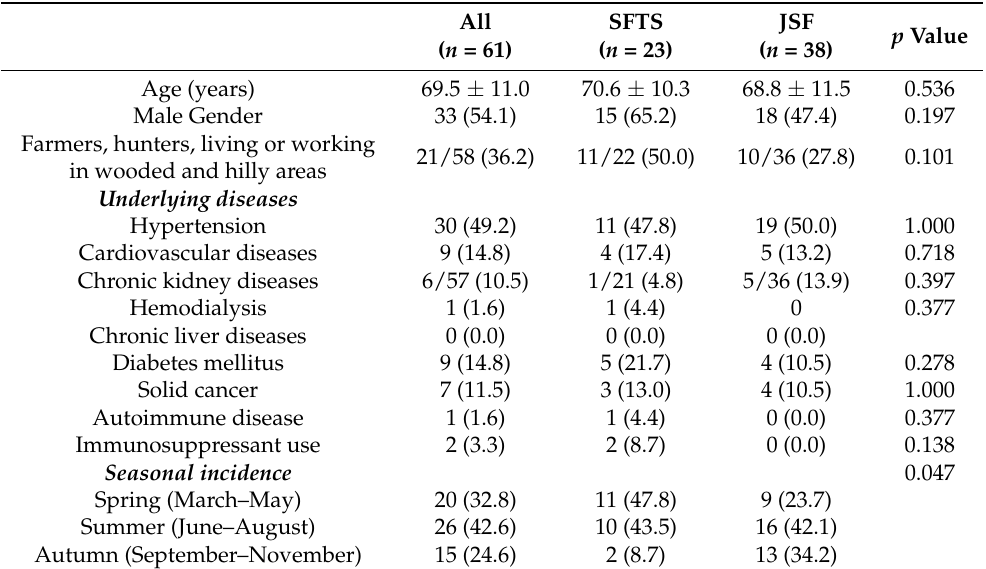
Table 1. Clinical characteristics in patients with SFTS or JSF.